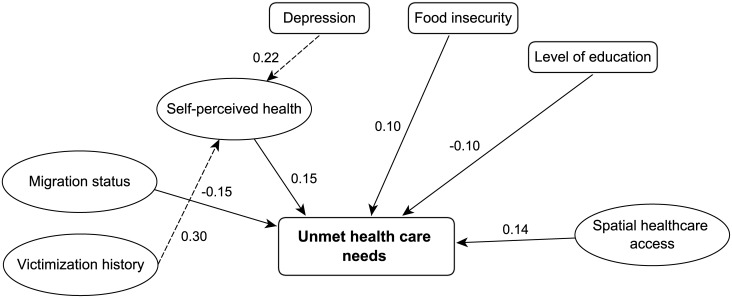
Final model of relationships between latent constructs of the unmet needs of homeless women and their characteristics.Ellipses: latent variables; boxes: observed variables. All coefficients have p values<0.05. Robust indices: CFI = 0.856 and RMSEA = 0.066 (CI95%[0.059–0.072]).